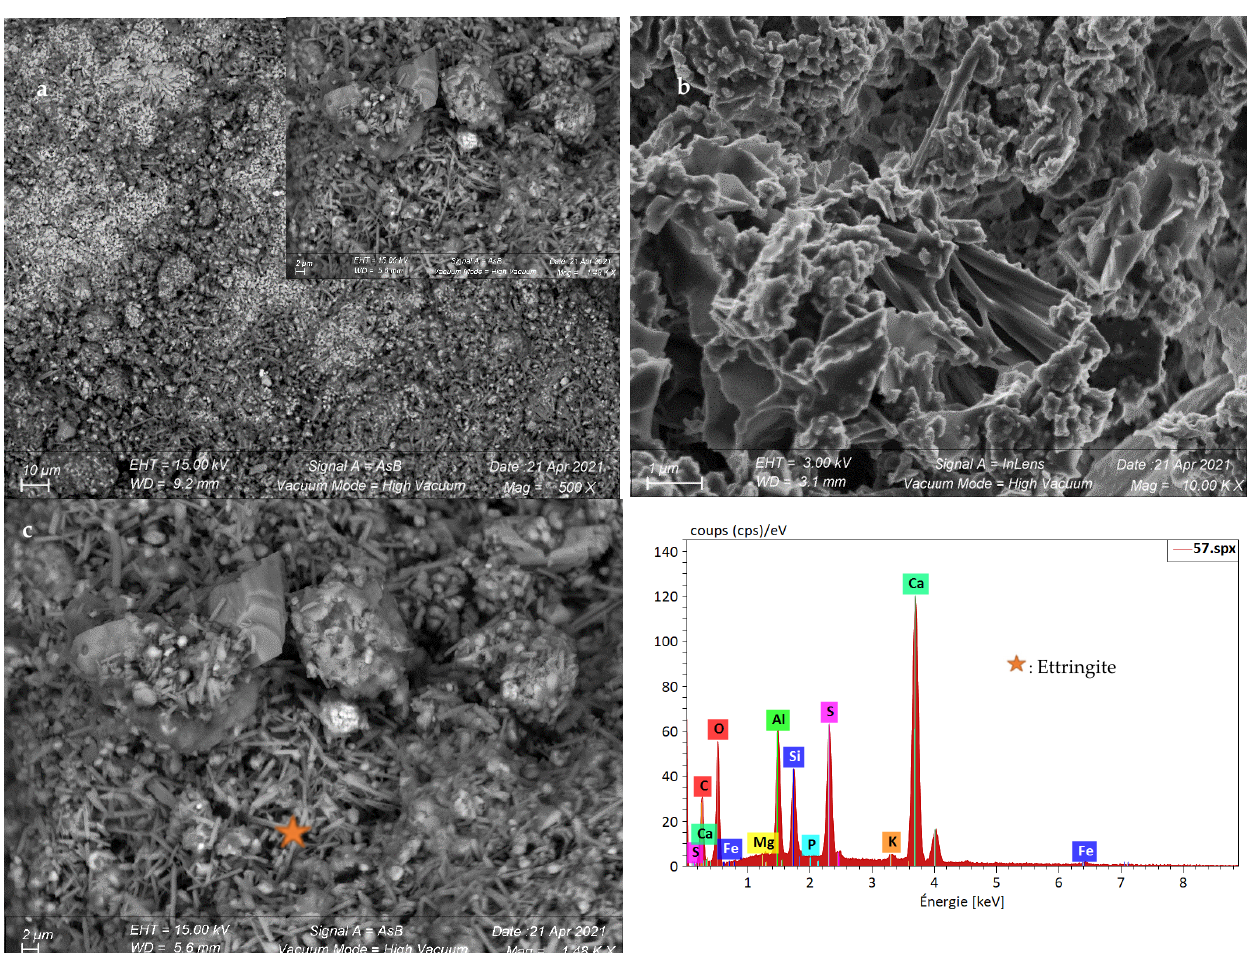
Figure 12. SEM micrographs showing the hydrated cement cured produced by indirect mechanosynthesis at 1200 °C cured for 7 days ( a,b ), EDS analysis of the sample ( c ).